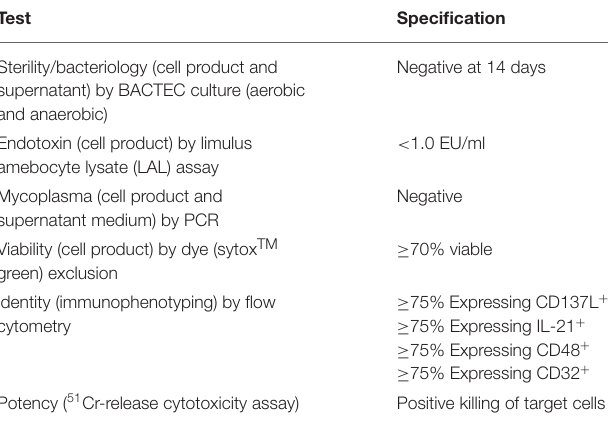
TABLE 1 | List of validation tests to qualify uAPC for use in GMP